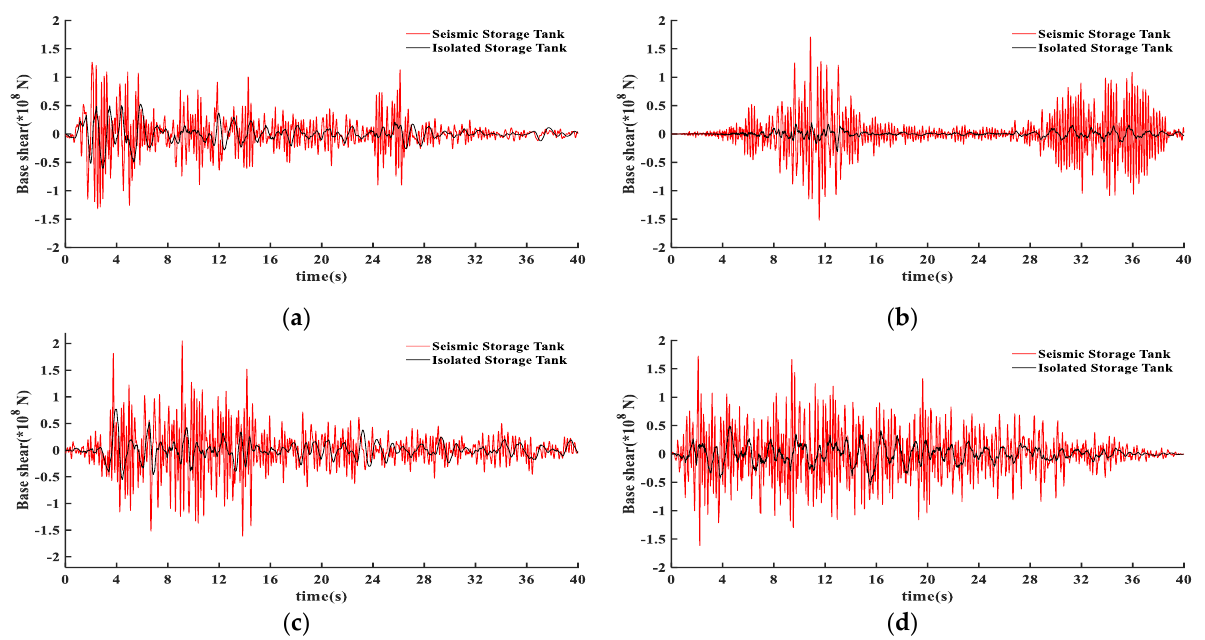
Figure 13. Base shear force: ( a ) El Centro wave; ( b ) Wolong wave; ( c ) Taft wave; ( d ) Artificial wave.